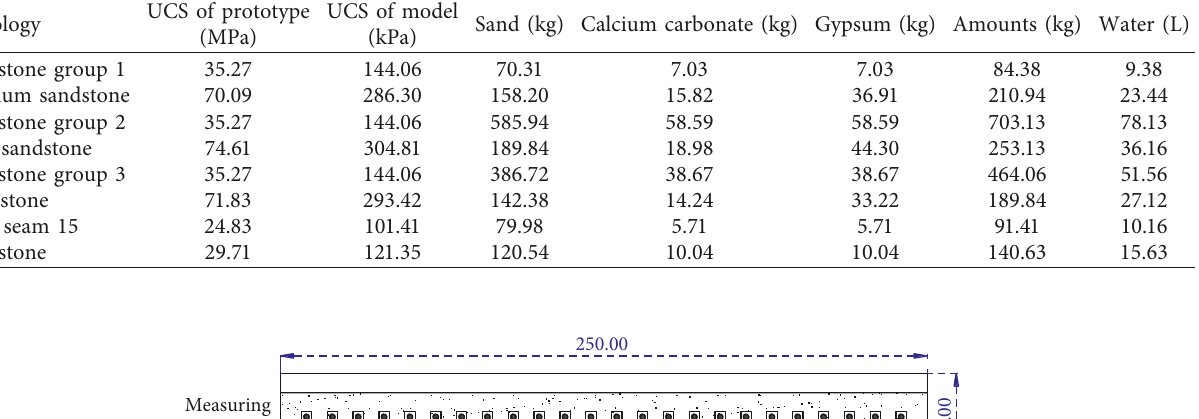
Table 1: Materials used in the physical model.